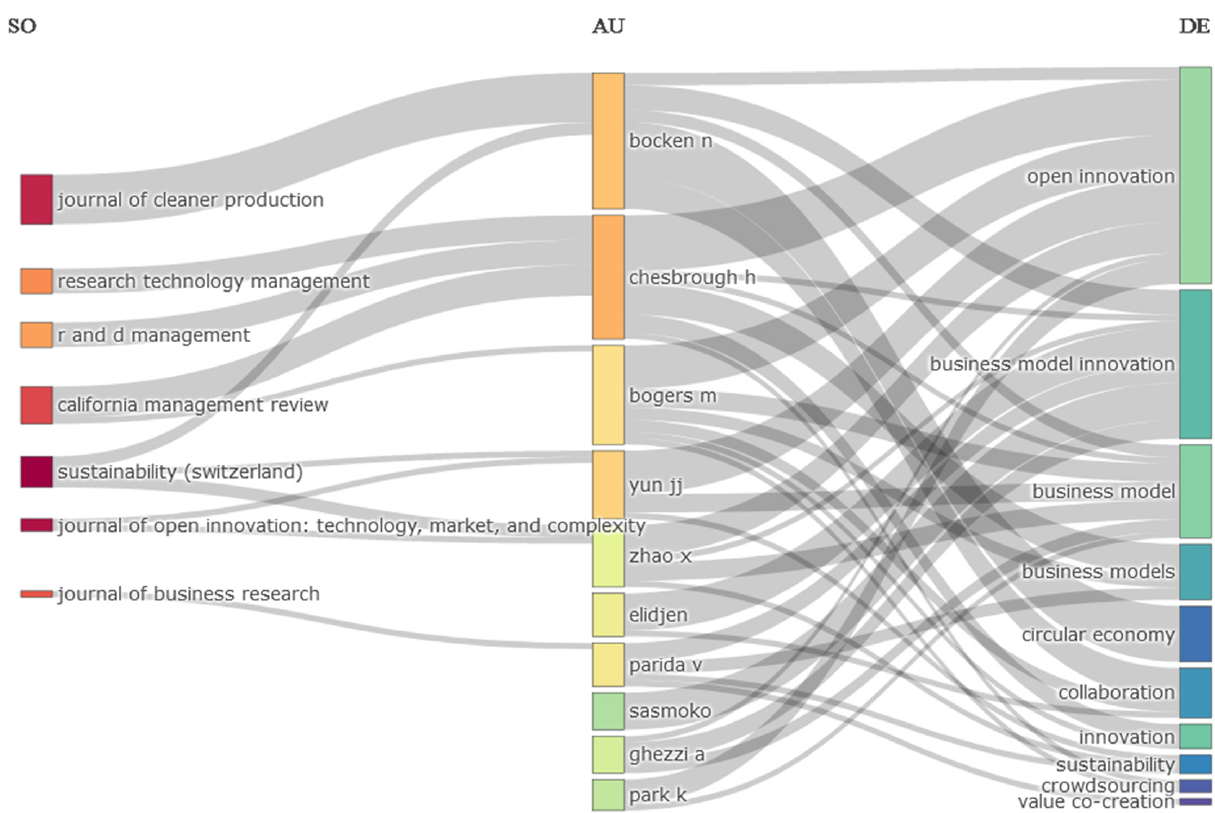
Figure 12. Relations between selected sources, authors, and authors’ keywords in the BM&OI literature. The analysis indicated that the most prolific authors in the BM&OI literature